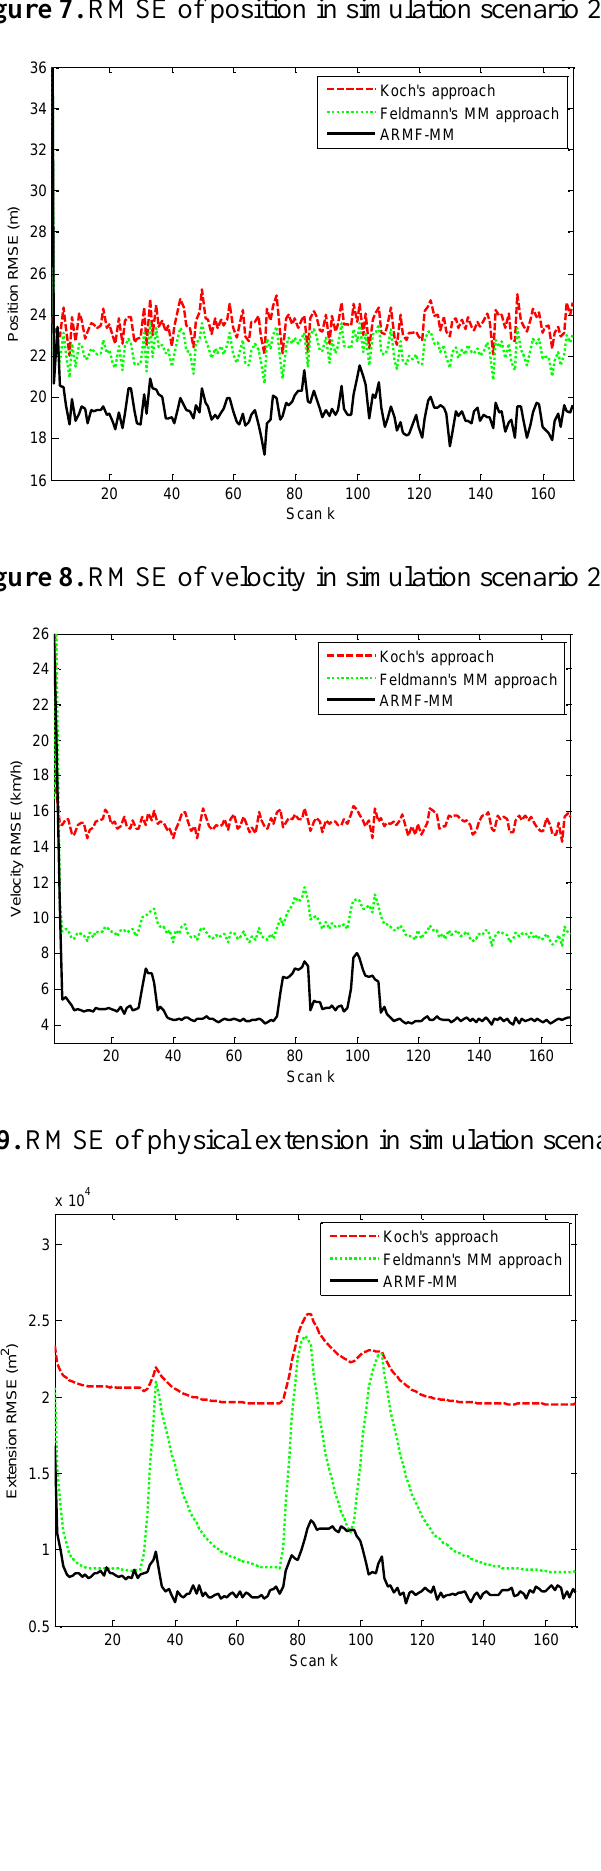
Figure 7. RMSE of position in simulation scenario 2.